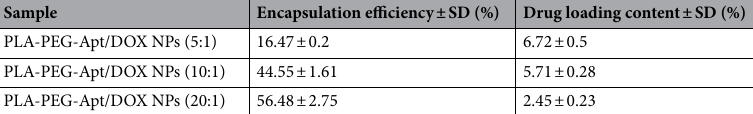
Table 2. Encapsulation efficiency and drug loading of PLA-PEG-Apt/DOX NPs.